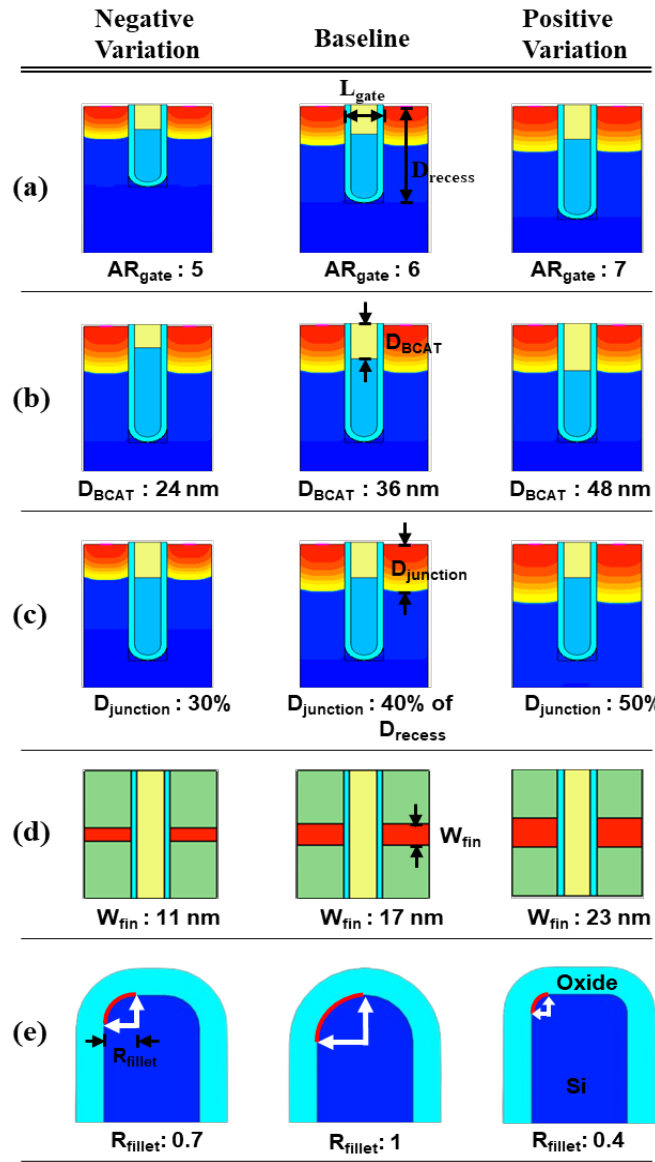
Figure 2. Parametric variations in the BCAT: ( a ) aspect ratio of the BCAT recess (D recess )-to-gate length (L gate ) (i.e., AR Gate = D recess /L gate ), ( b ) BCAT depth (D BCAT ), ( c ) junction depth (D junction ), ( d ) fin width (W fin ), and ( e ) fin fillet radius (R fillet ). The impacts of structural variations in baseline device on its electrical characteristics were investigated. The aspect ratio of D recess to L gate (i.e., AR gate ) varied from 5 ( − 17% of the baseline) up to 7 (+17% of the baseline). Note that the AR gate of the baseline device structure was 6. The BCAT depth (D BCAT ) varied from 24 nm ( − 33% of the baseline) to 48 nm (+33% of the baseline). Note that the D BCAT of the baseline device was 36 nm. The D junction (which is defined as the depth at which the doping concentration is 10 17 cm − 3 ) varied from 30% to 50% of the D recess . The saddle fin width (W fin ) varied from 11 nm to 23 nm (i.e., − 33 ~ +33% of the baseline value). Note that the nominal saddle fin width (W fin ) of the baseline device was 17 nm. The saddle fin fillet radius (R fillet ) of the baseline device was 1.0, and it varied from 0.4 ( − 60% of the baseline) to 0.7 ( − 30% of the baseline). For each structural variation mentioned above, the input/output characteristics (i.e., I D -vs. -V G /I D -vs.-V D ) were simulated (see Table